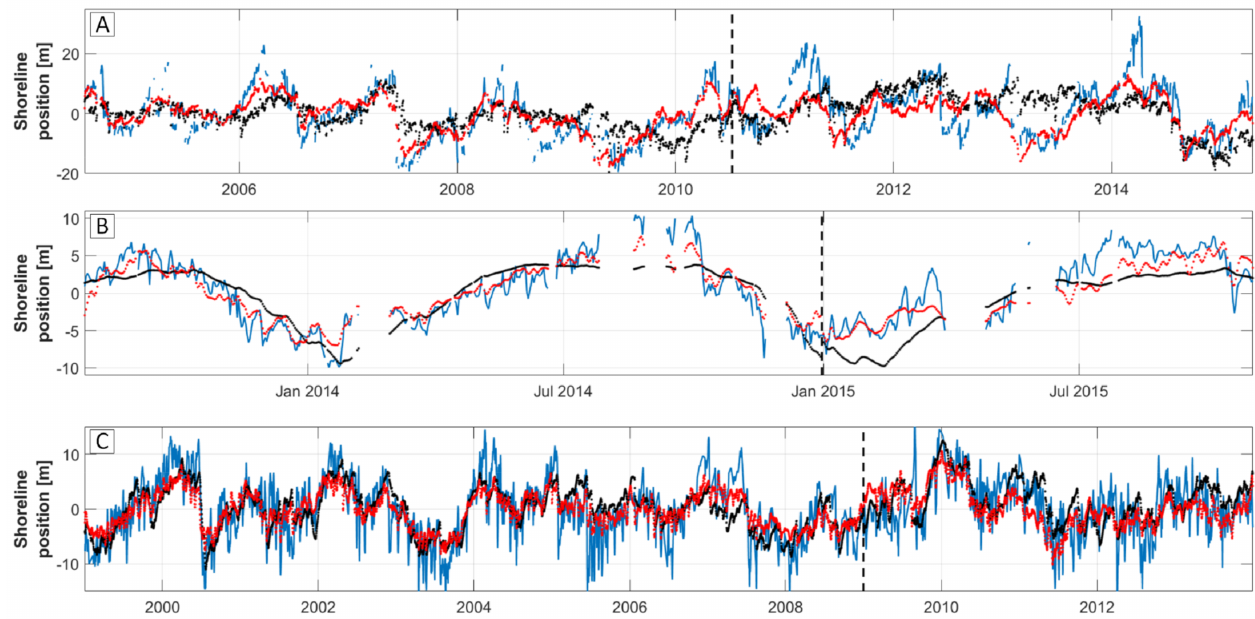
Figure 5. Model calibration and validation results using SF-ST (black) and SF-MT (red) for the dataset at Narrabeen ( A ), Nha Trang ( B ) and Tairua ( C ). Note that the measured data is indicated in blue. The black dashed line indicates the discrimination between the calibration and validation